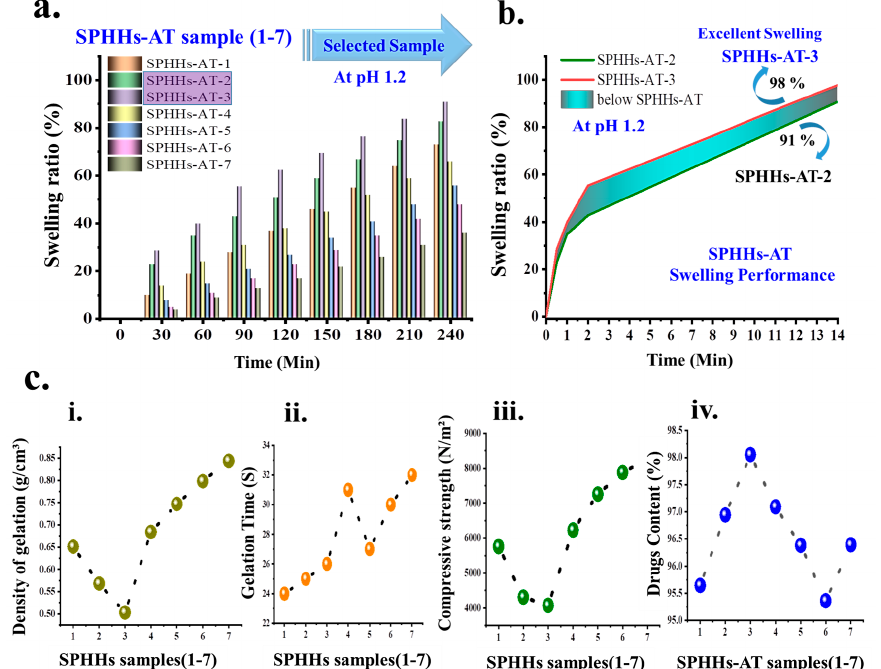
Figure 2. ( a , b ) The pH-dependent swelling appearance of SPHHs-AT (pH 1.2) phosphate buffer solutions (PBS) indicates their performance. ( c ) The comparative study of a series of SPHHs samples as ( i ) assigned as apparent density; ( ii ) the performance of gelation kinetics; ( iii ) mechanical strength leading as semi-IPNs; ( iv ) uniform drug content.